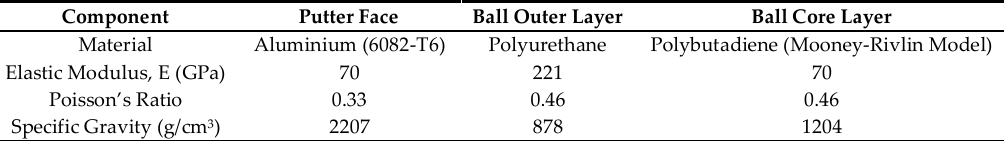
Table 1. Material properties inputted for the simulation procedure.